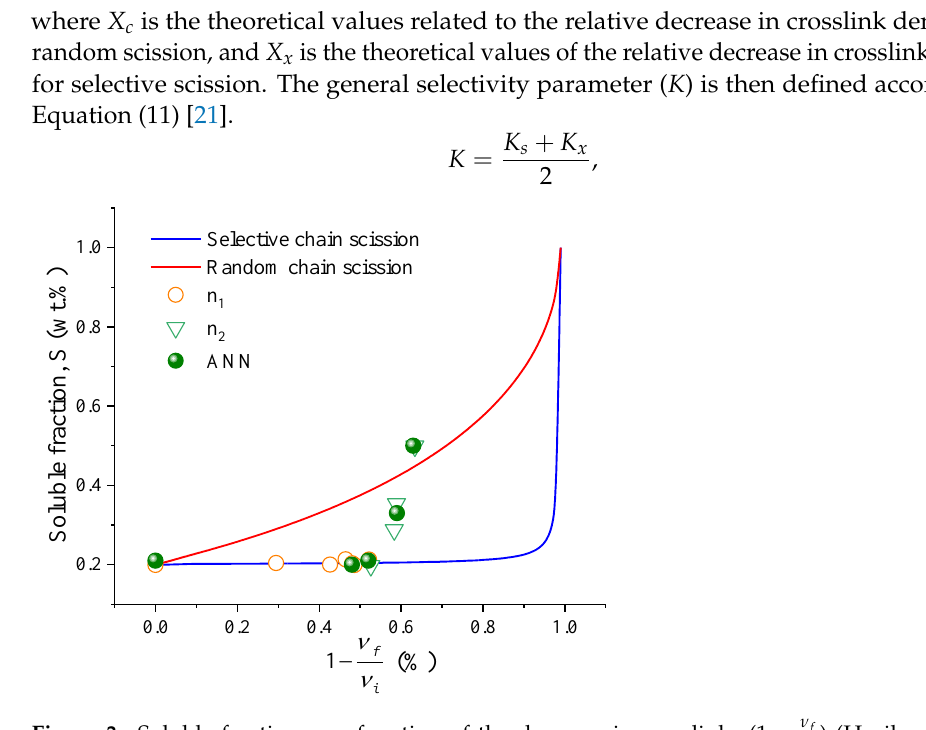
Figure 3. Soluble fraction as a function of the decrease in crosslinks (1 − ν f The red line represents the theoretical random scission curve, the blue line selective scission, and ANN-generated green dots.